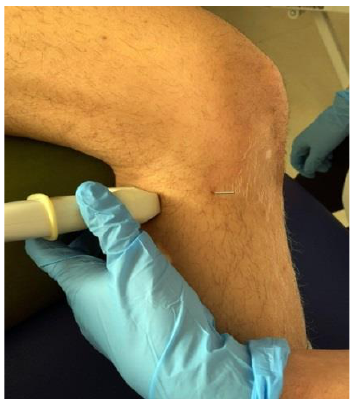
Figure 2. Position of the probe in relation to the needle. The needle was observed in a long axis, so that the entire length of the needle could be seen in the image. Figure 3 shows the ultrasound image of the popliteus muscle, in the deepest part, just below the vasculonervous